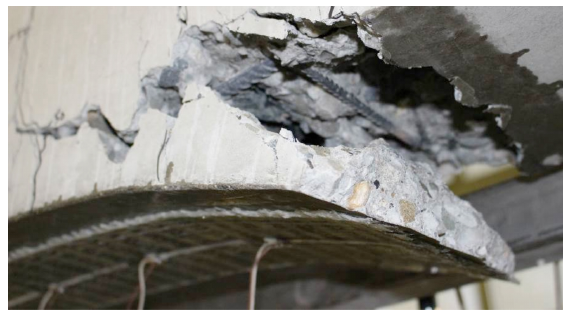
Figure 8: Failure of RC beam strengthened with Carbon Fibre Rein- forced Polymer smart-textile.